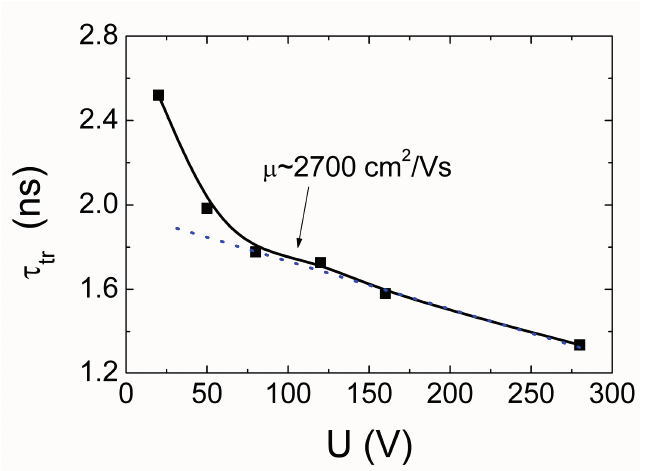
Figure 15. The transit time evaluated from the deconvoluted current transients as a function of applied voltage using an approximation of the flat vertex of